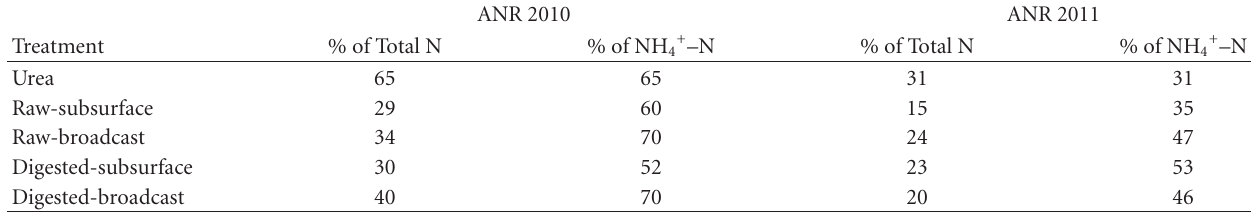
Table 7: Apparent nitrogen recovery (ANR) in harvested forage as percentage of total and ammonium N applied, 2010 and 2011.